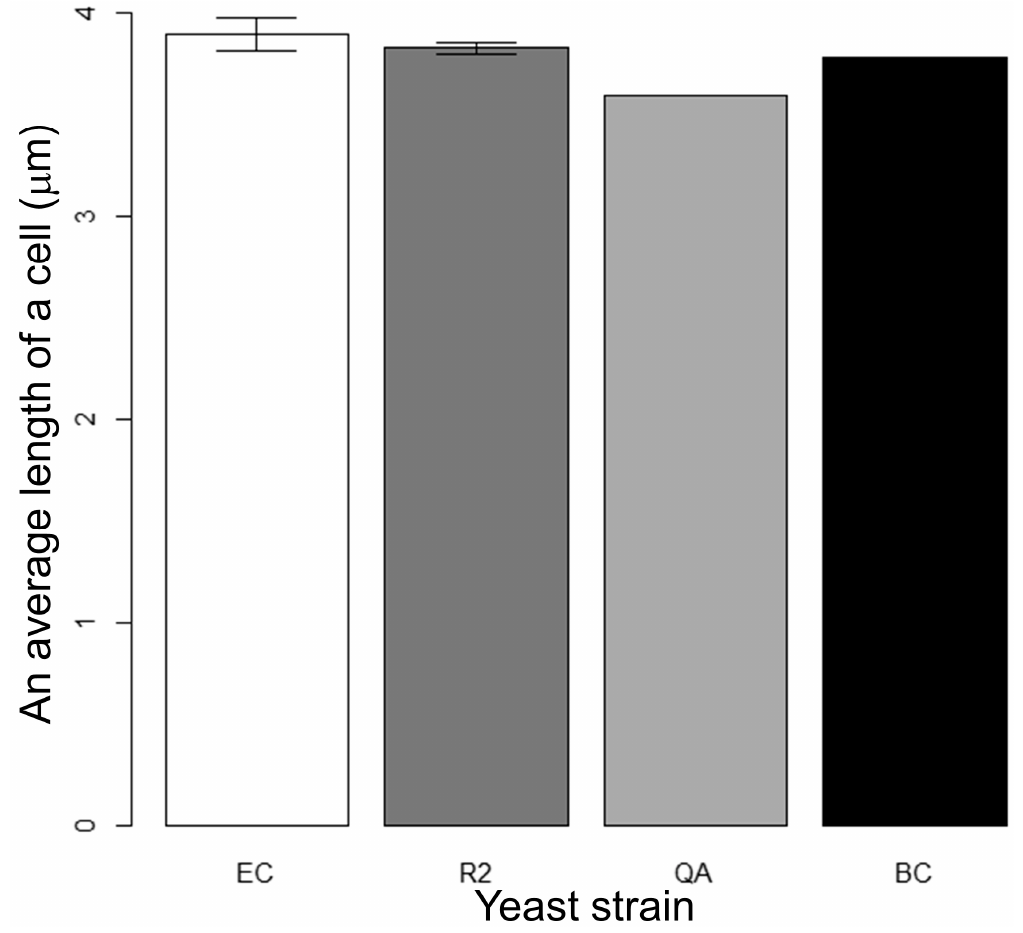
Figure 7. Lengths of cells measured using the cell count machine [6]. The experiment is performed a minimum of three times, and more than 90 cells are measured for each value. Means and standard deviations are presented with error bars. Significance differences were observed between R2 and QA as well as QA and BC ( p -values were 0.02 and 0.01, respectively, <0.05). No significant differences were observed between EC and R2, EC and QA, and EC and BC ( p -values were 0.67, 0.10, and 0.42, respectively, >0.05). Notably, the p -value between R2 and BC could not be calculated.